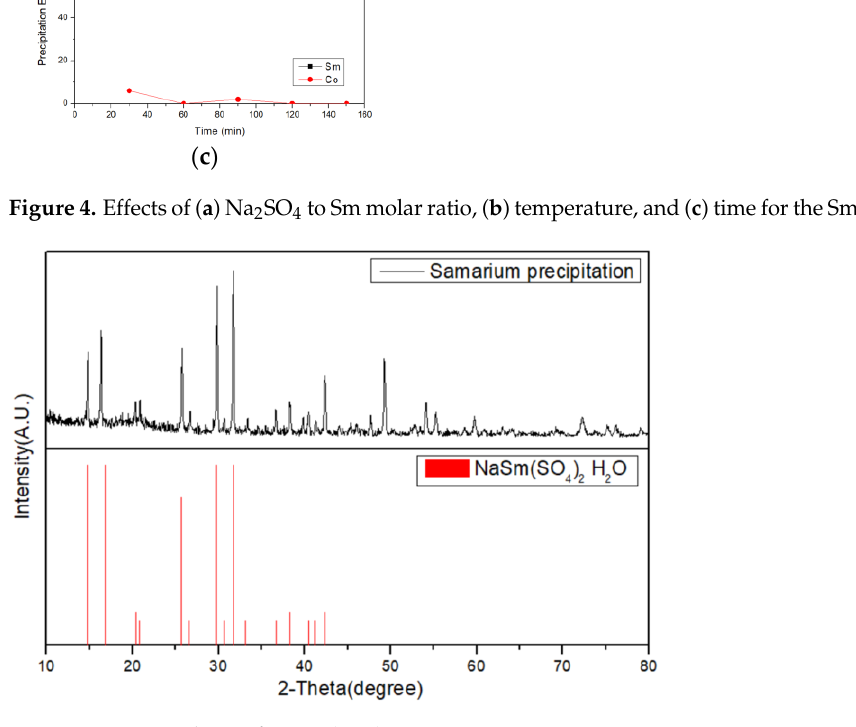
Figure 4. Effects of ( a ) Na 2 SO 4 to Sm molar ratio, ( b ) temperature at Na 2 SO 4 :Sm ratio of 4:1, and ( c ) time for the Sm precipitation at Na 2 SO 4 : Sm ratio of 4:1.